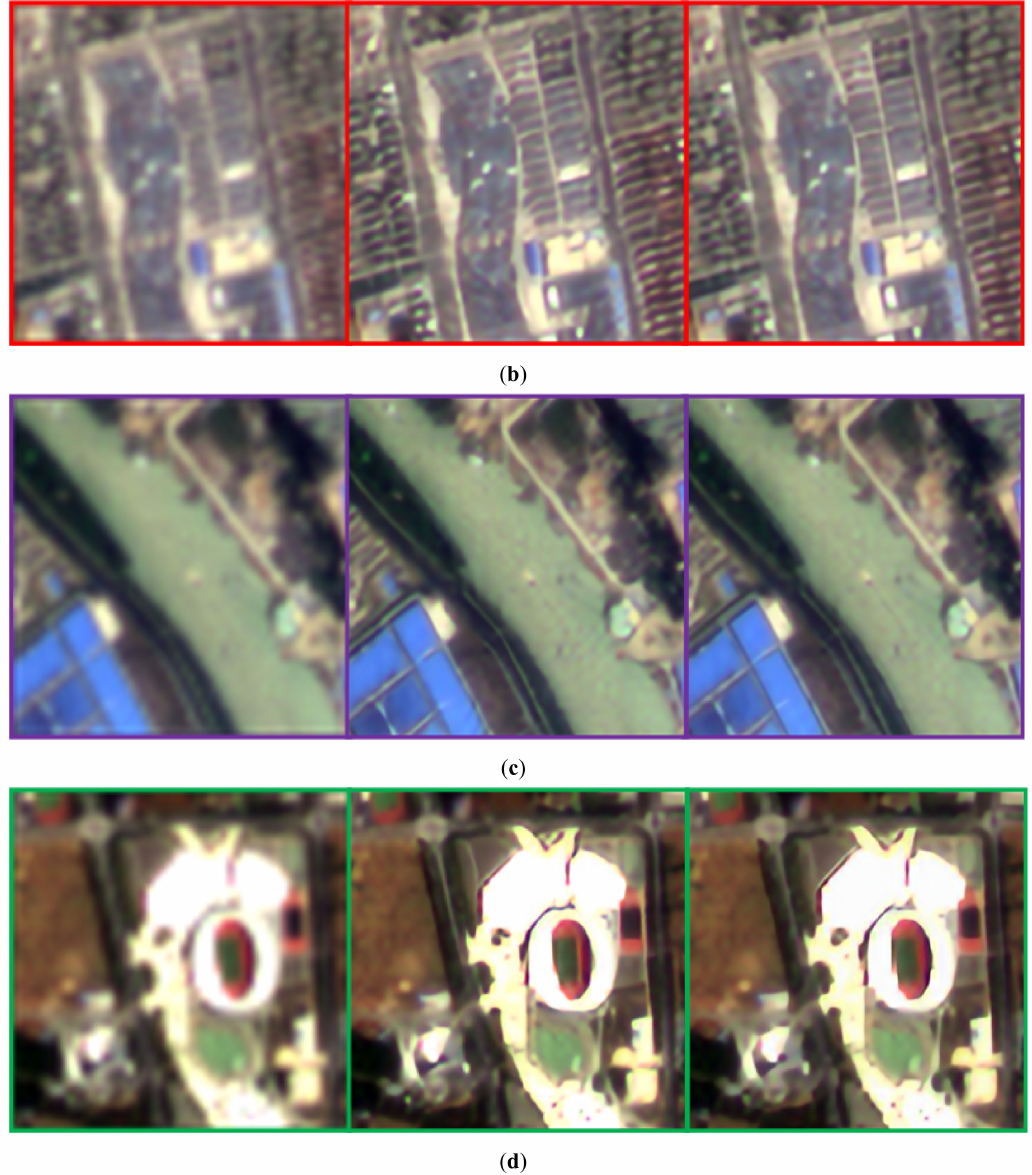
Figure 12. Performance comparison of the Bicubic model, MSRN, and PMSRN when applied to remote-sensing images in each group of pictures, for all r values. From left to right are the Bicubic, MSRN, and PMSRN results. Compared with other methods, the PMSRN SR image exhibits the best edge detail. The up-sampling factors r values are ( a ) 2, ( b ) 3, ( c ) 4, and ( d )